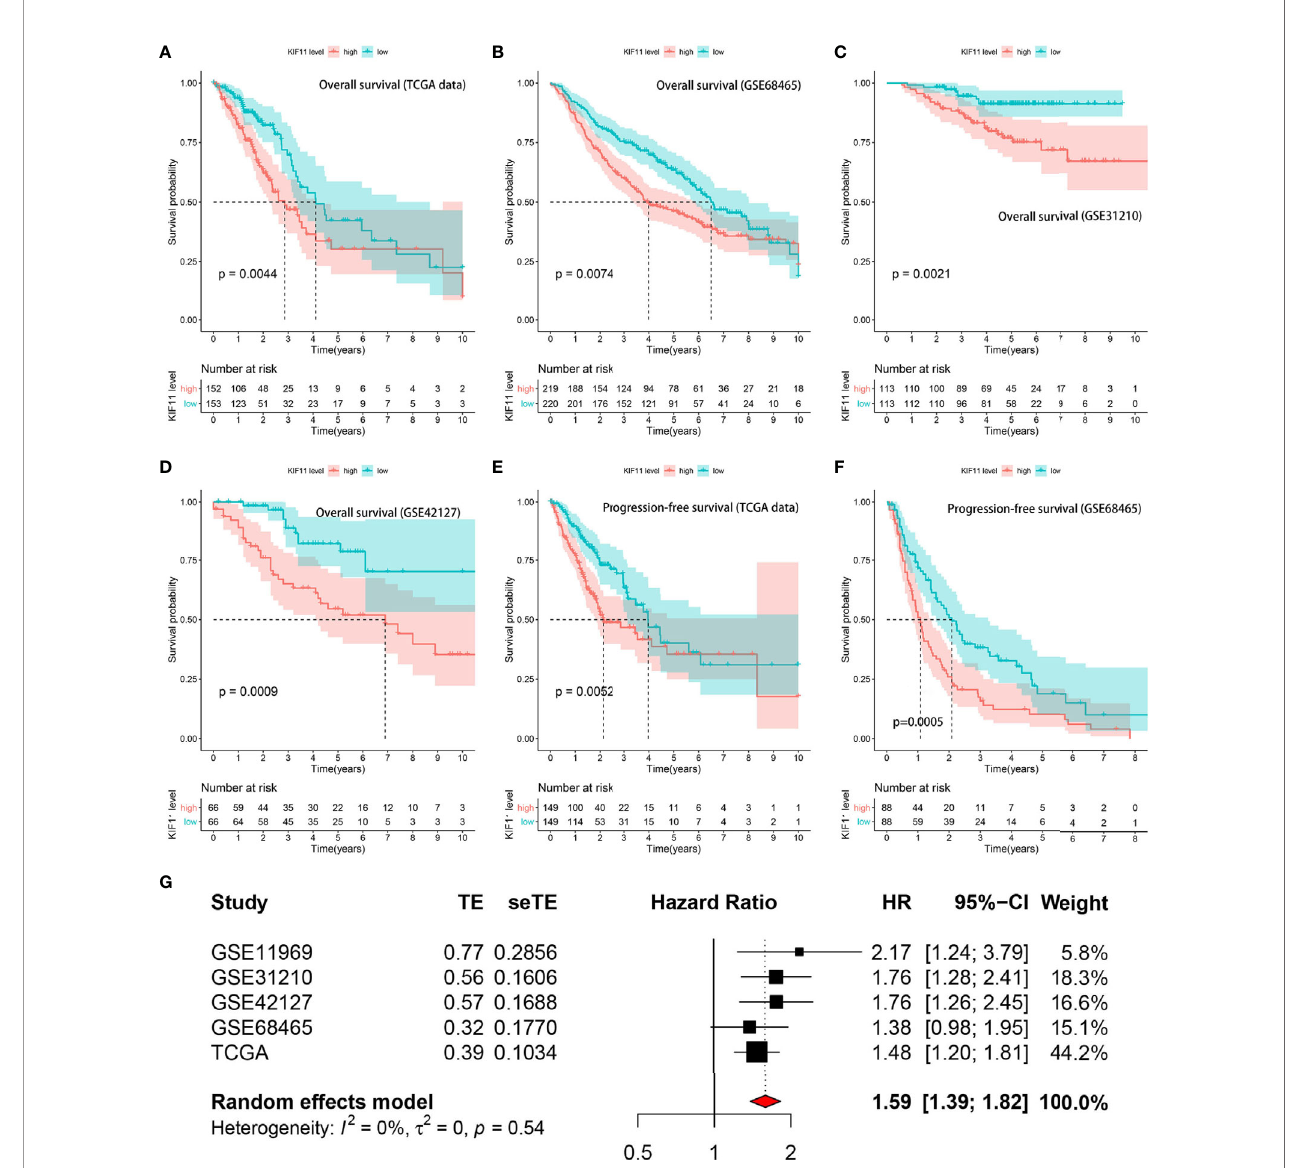
FIGURE 5 | Correlation of KIF11 expression with the LUAD patient survival. Higher KIF11 expression predicted poor OS according to the (A) TCGA dataset, (B) GSE68465, (C) GSE31210, and (D) GSE42127 pro fi les. LUAD patients were classi fi ed into high and low KIF11 expression subgroups relative to the median KIF11 expression level. Higher KIF11 expression predicted a worse PFS in both the (E) TCGA dataset and (F) GSE68465 pro fi le. Meta-analysis associated KIF11 expression with the OS in fi ve cohorts (G)